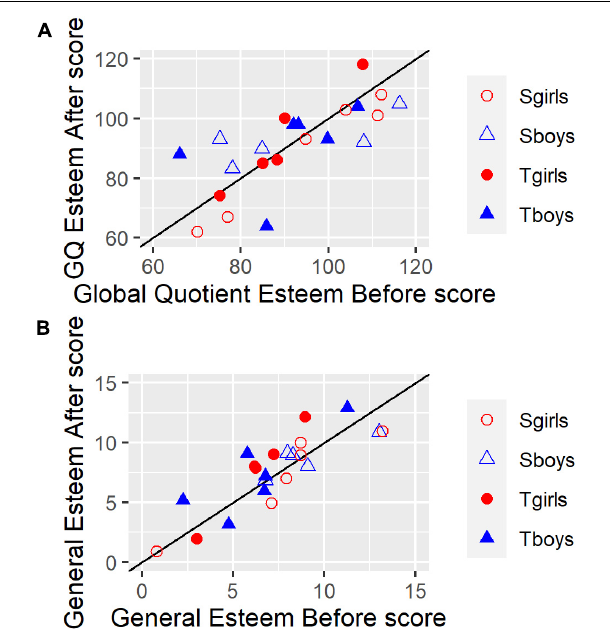
FIGURE 5 | CFSEI-3 Before and After scores for each of 22 participants. (A) Global Quotient. (B) General Self-Esteem subscale. Symbols indicate subgroups. Filled symbols: Turn-taking. Open symbols: Synchrony. Red circles: girls. Blue triangles: boys. Datapoints with identical values are slightly offset on the x -axis so they can be seen. The solid black diagonal line shows x = y , i.e., a symbol appearing on this line indicates no change between Before and After Scores. Higher After than Before scores lie above the line, and lower ones lie below the